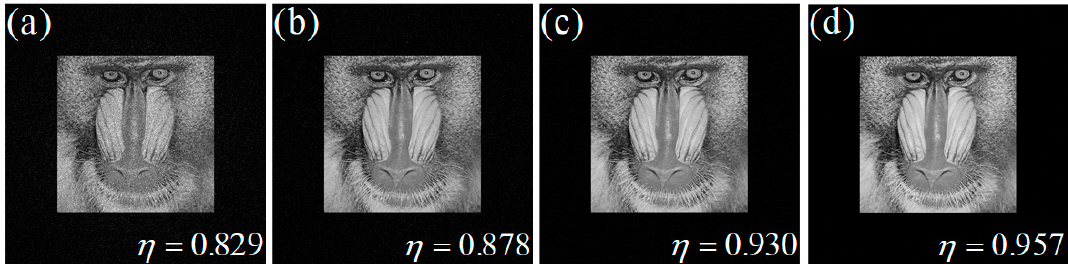
Figure 5. Numerical reconstructions with WCIA: ( a ) 3 iterations; ( b ) 10 iterations; ( c ) 30 iterations; ( d ) 100 iterations.